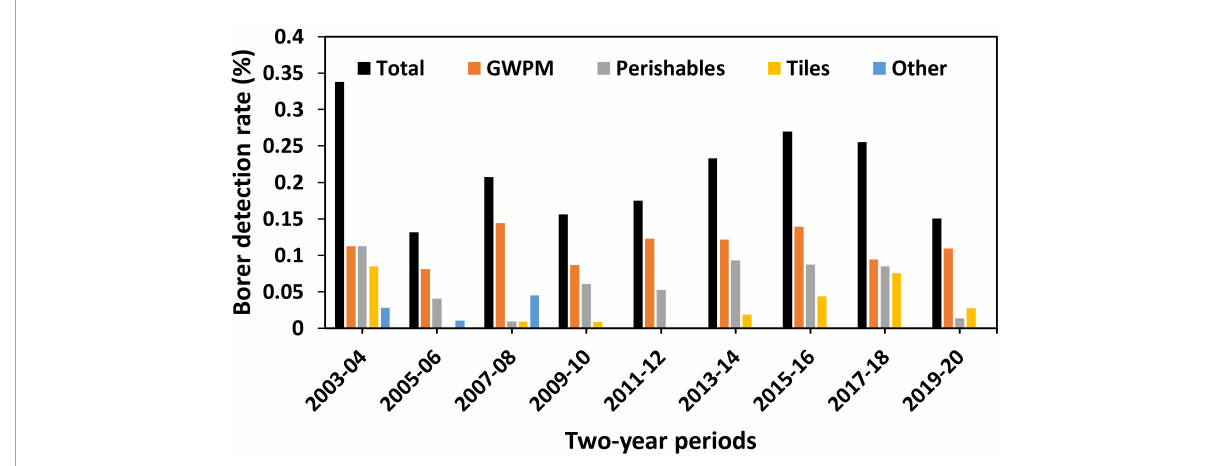
FIGURE8 Detection rates for wood borers in WPM at US ports averaged over 2-year periods for AQIM final dataset 2003–2020 by selected AQIM survey programs (see section “Materials and methods”) and for all survey programs combined (total).